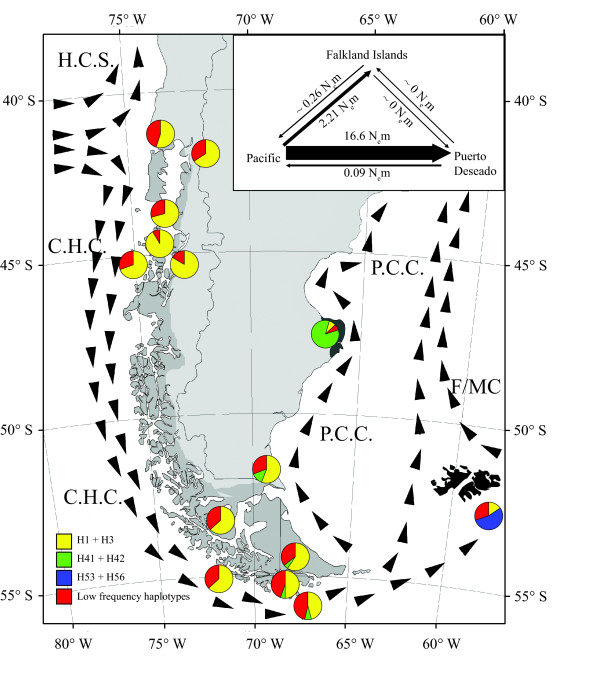
Prevailing direction of currents and winds in southern South America and frequency of the dominant haplotypes in each locality. H.C.S.=Humboldt Current System; C.H.C.=Cape Horn Current, M/FC=Falkland/Malvinas Current; P.C.C. Patagonian Coastal Current. Migration rate measured as effective number of migrants (Nem) among the main areas in Patagonia (Pacific Patagonia, Puerto Deseado and the Falkland/Malvinas Islands).